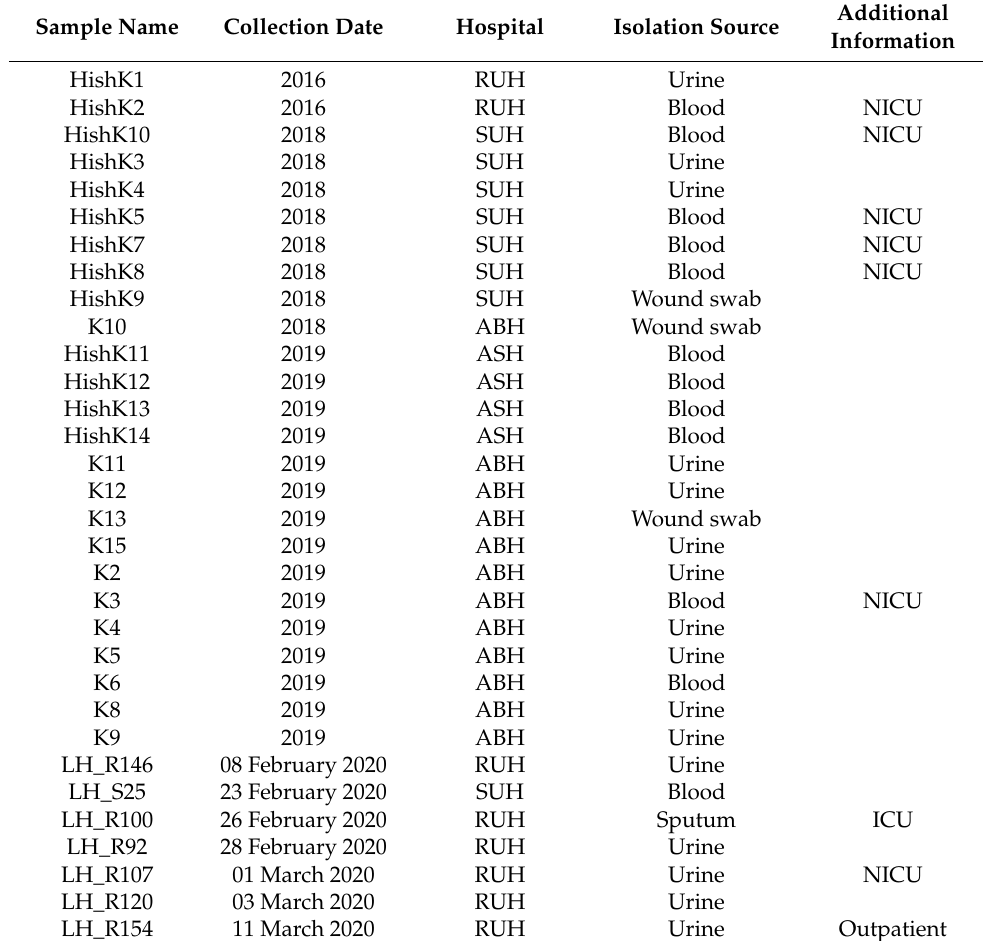
Table 1. Isolate details: date and type of sample, and hospital.